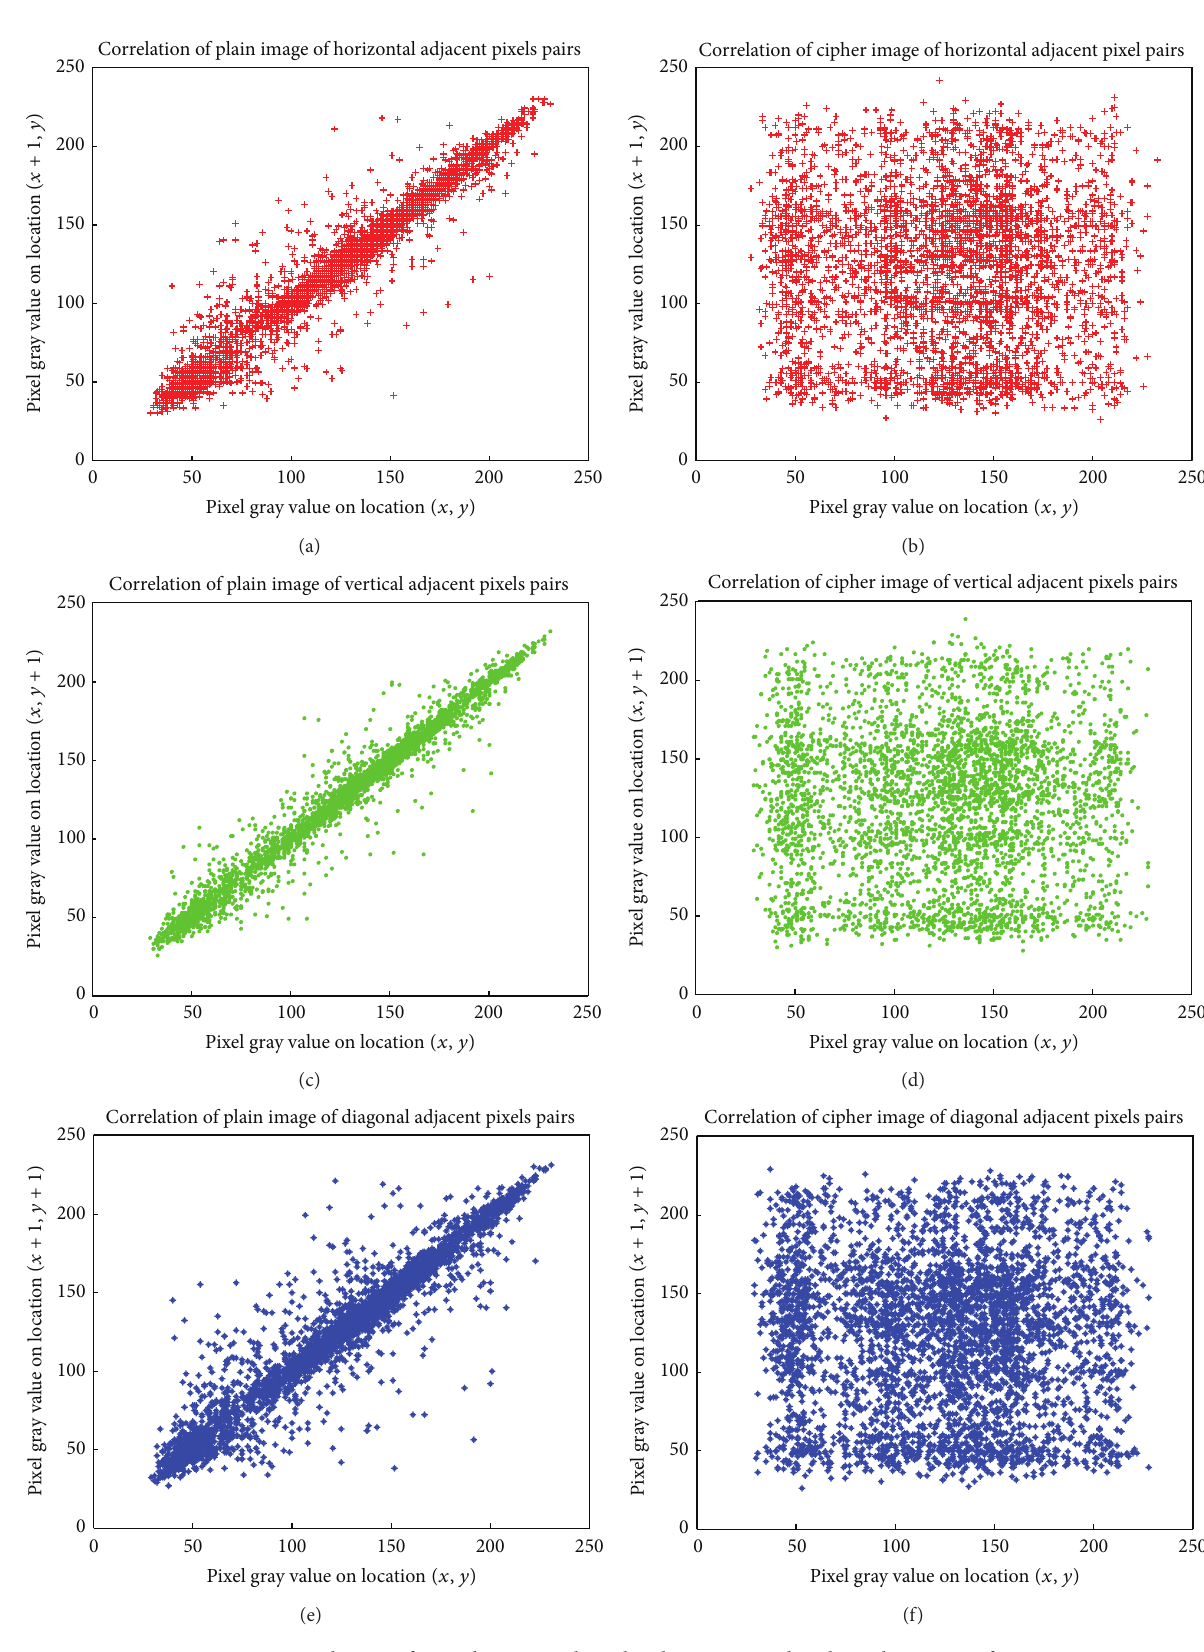
Figure 6: Correlations of two adjacent pixels in the plain image and in the cipher image of